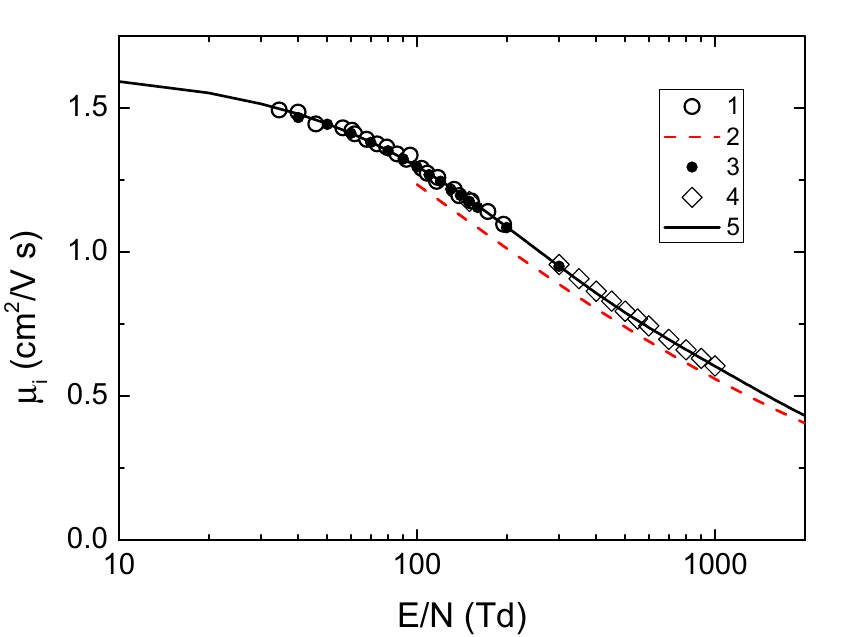
Figure 8. The mobility of Ar + ions reduced to normal conditions in argon at a temperature of 300 K as a function of the reduced field E/N: 1—experimental data [29], 2—approximation from [30], 3—work [33], 4—[34], 5—approximation Equation (10).